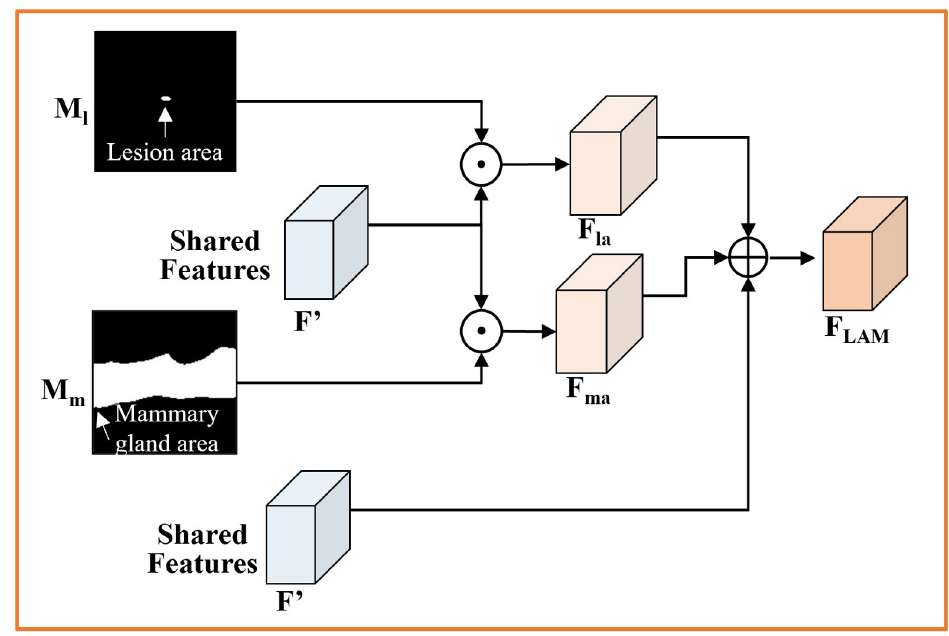
Fig 6. Schematic of Lesion Attention Module (LAM). � denotes element-wise multiplication and � denotes element-wise addition.